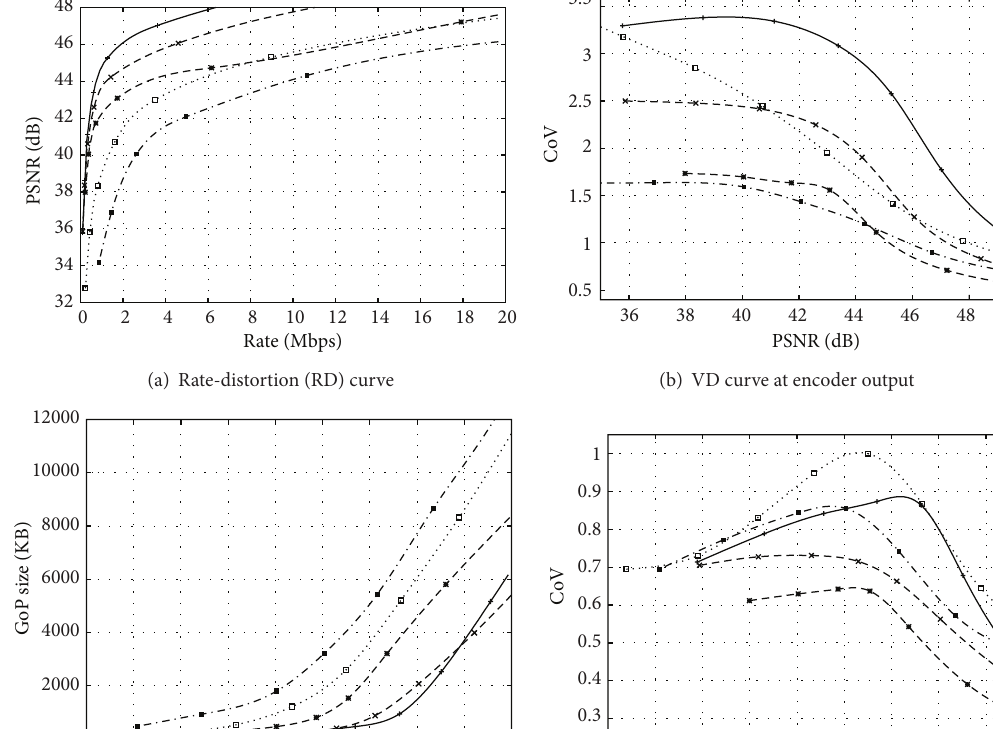
Figure 4: Traffic characteristics and link bandwidth requirements for H.265/HEVC with cascading QPs for a variety of videos, as well as comparison of H.265/HEVC (with cascaded QPs) with H.264/AVC (with cascaded QPs) for Tears of Steel (ToS) video.